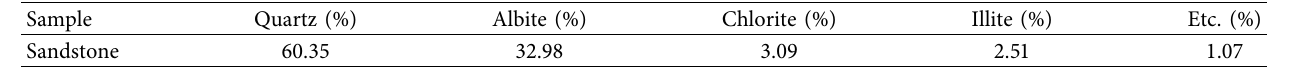
Table 1: Results of the petrographic study and XRD analysis for the sandstone